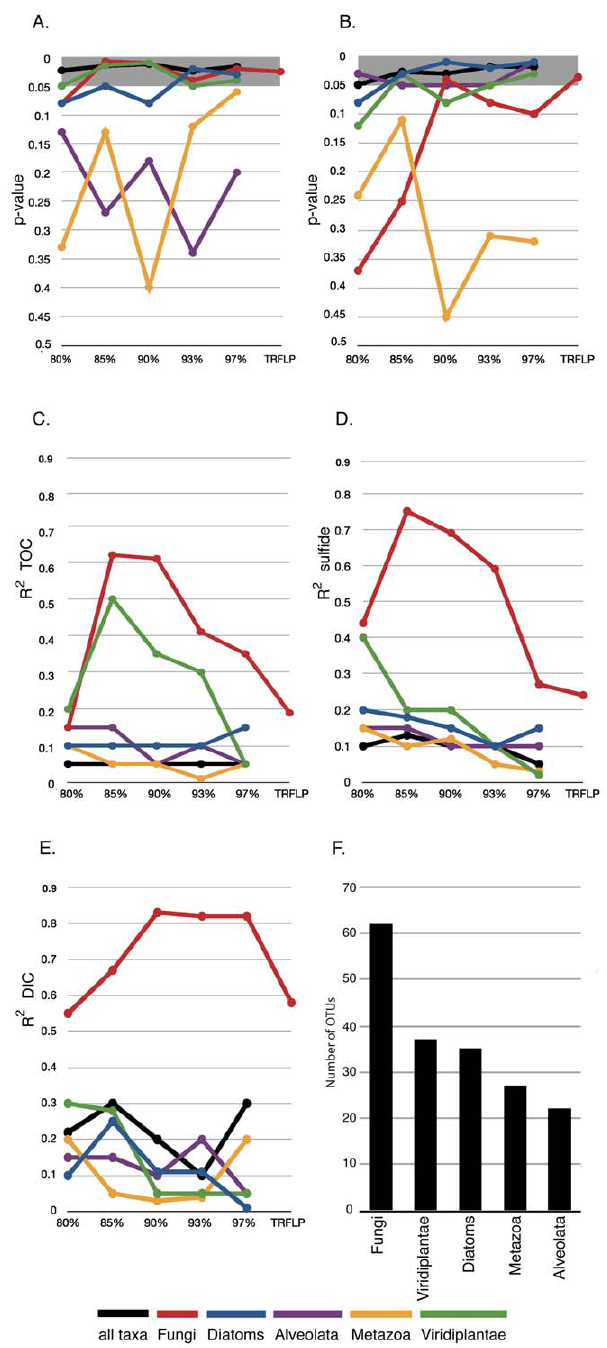
Figure 2. Multi-Response Permutation Procedure (MRPP) and Canonical Correspondence Analysis (CCA) performed on eukaryotic rRNA OTUs sharing 80–97% sequence identity, as well as fungal TRFLP patterns (denoted as ‘TRFLP’ on the right hand side of each plot). (A) MRPP analysis of the combined effect of TOC, DIC, and sulfide and (B) sediment depth on subsurface eukaryotic distributions. Statistically significant p-values ( , 0.05) are highlighted. CCA correlation values (R 2 ) of TOC (C), sulfide (D), and DIC (E) with different eukaryotic taxa in subsurface samples. (F) OTU richness of eukaryotic taxa detected in marine subsurface samples.